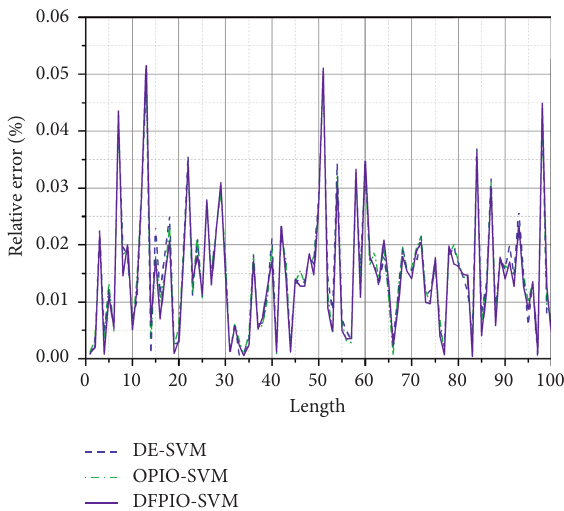
Figure 8: The prediction error curves of three methods for NARMA.